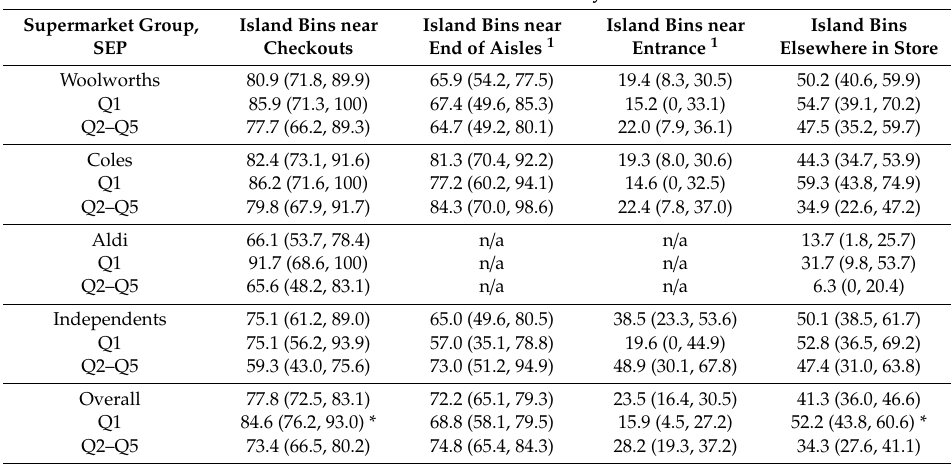
Table 3. Mean proportion (%) of price-promoted food and beverage display space dedicated to unhealthy products for each in-store island-bin location, by supermarket group and area-level socio-economic